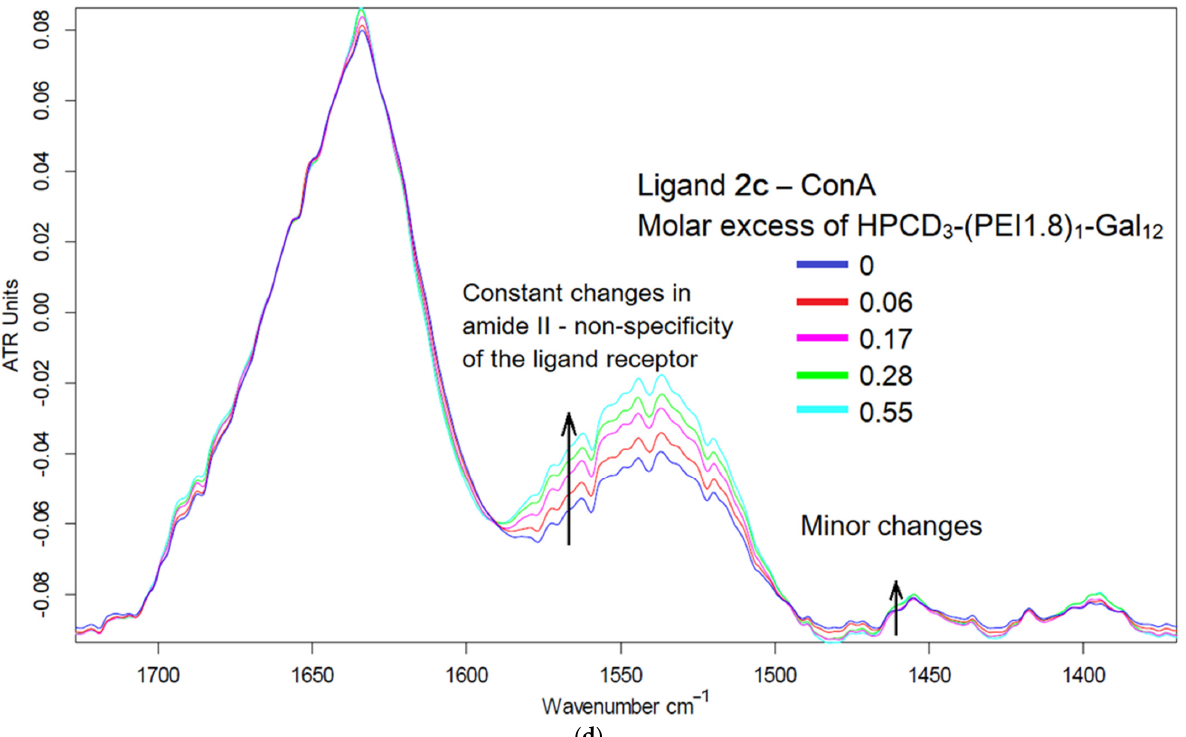
Figure 4. Fourier transform infrared spectra of ConA and ConA complexes with ( a ) mannan-amCD, ( b ) ligand 2a, ( c ) ligand 2b and ( d ) ligand 2c. C 0 (ConA subunit) = 0.1–0.15 mM. Natrium–phosphate buffer solution (0.02 M, pH 6.4). C(Ca 2+ ) = C(Mn 2+ ) = 1 mM. T = 22 °C. Ligand spectra were subtracted